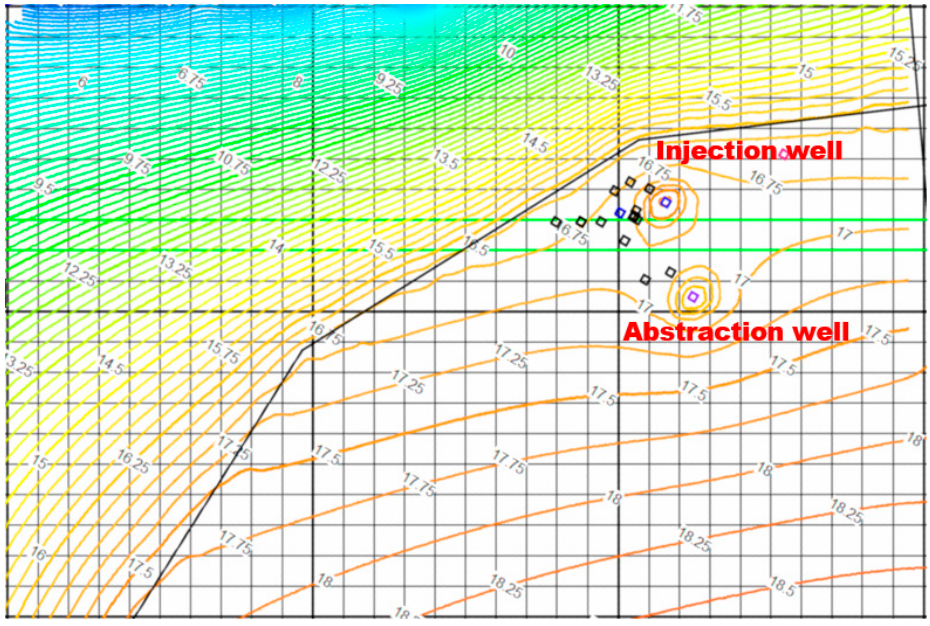
Figure 11. Hydraulic impact after 20 years of ATES operation in scenario 2.